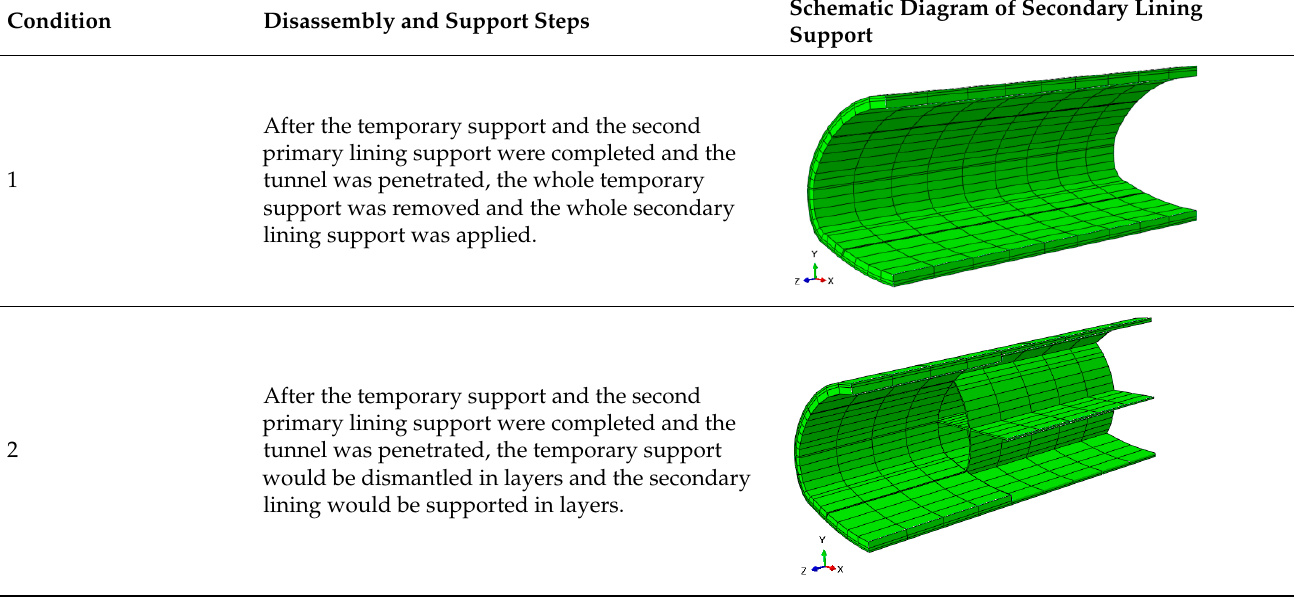
( b ) Figure 20. The vertical displacement of the lining after the temporary support was removed (unit: m): ( a ) Condition 1 and ( b ) Condition 2. ( a ) ( b ) Figure 21. The vertical displacement of lining after the construction of the secondary lining (unit: m): ( a ) Condition 1 and ( b ) Condition 2.